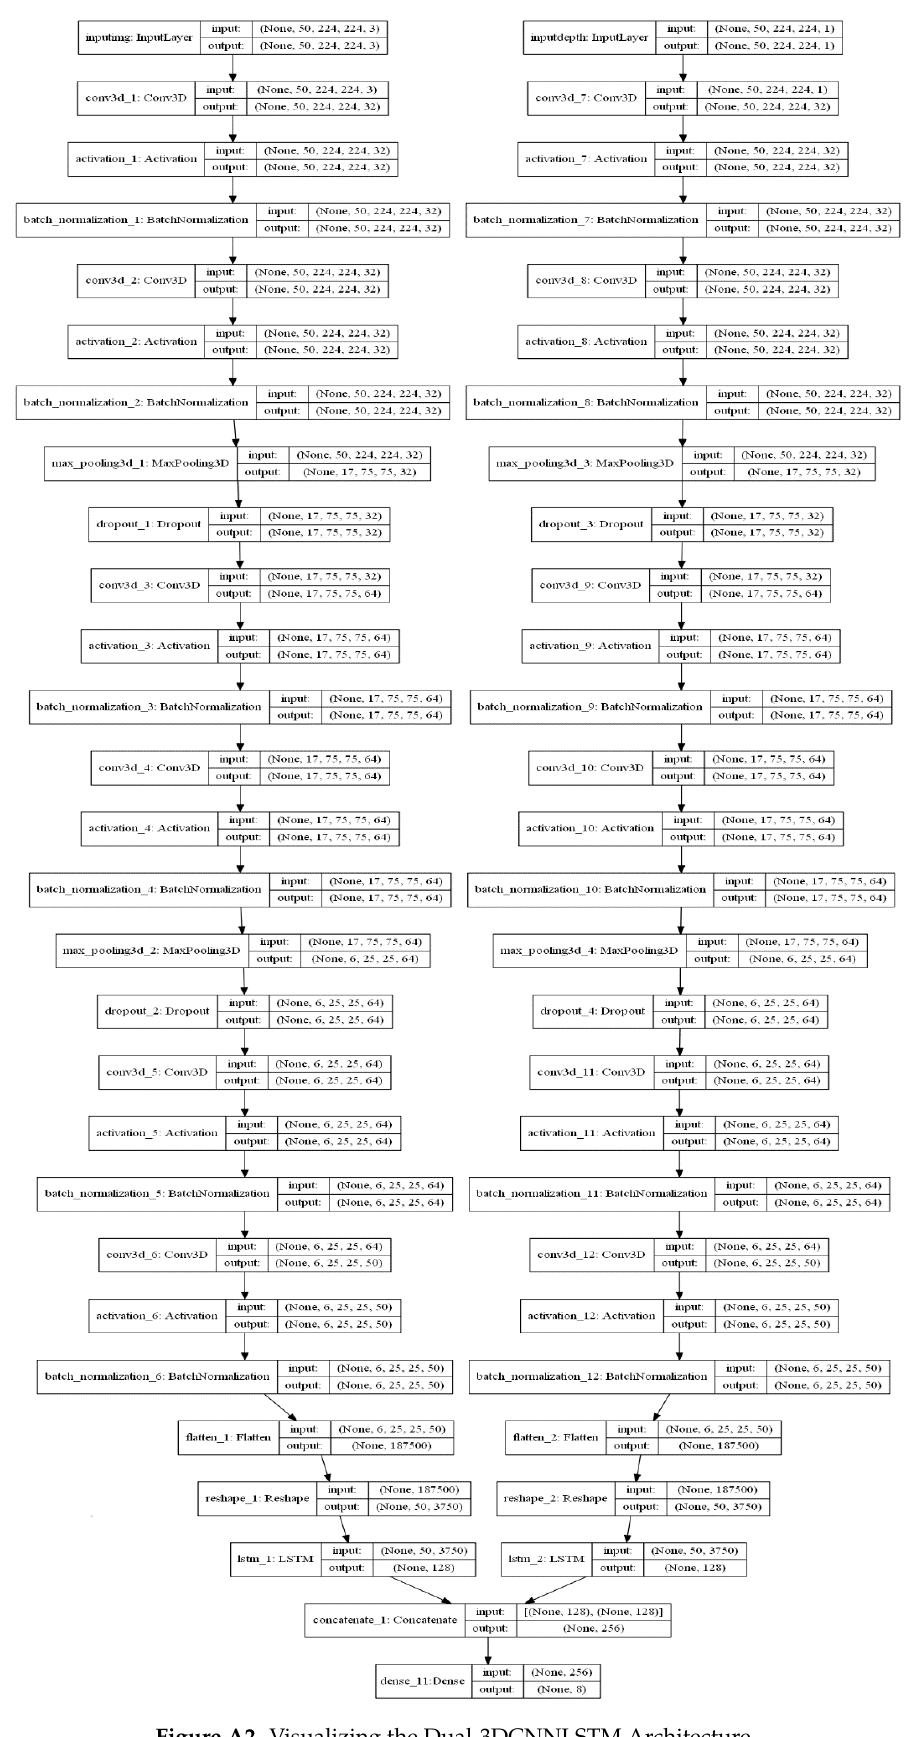
Figure A2. Visualizing the Dual-3DCNNLSTM Architecture.